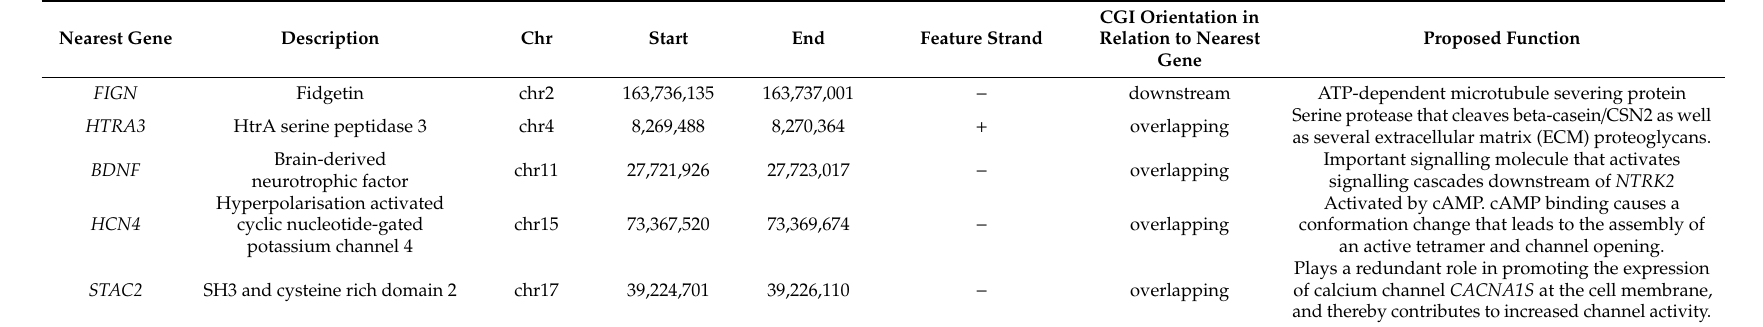
Table 1. Methylated candidate CGIs for colorectal cancer